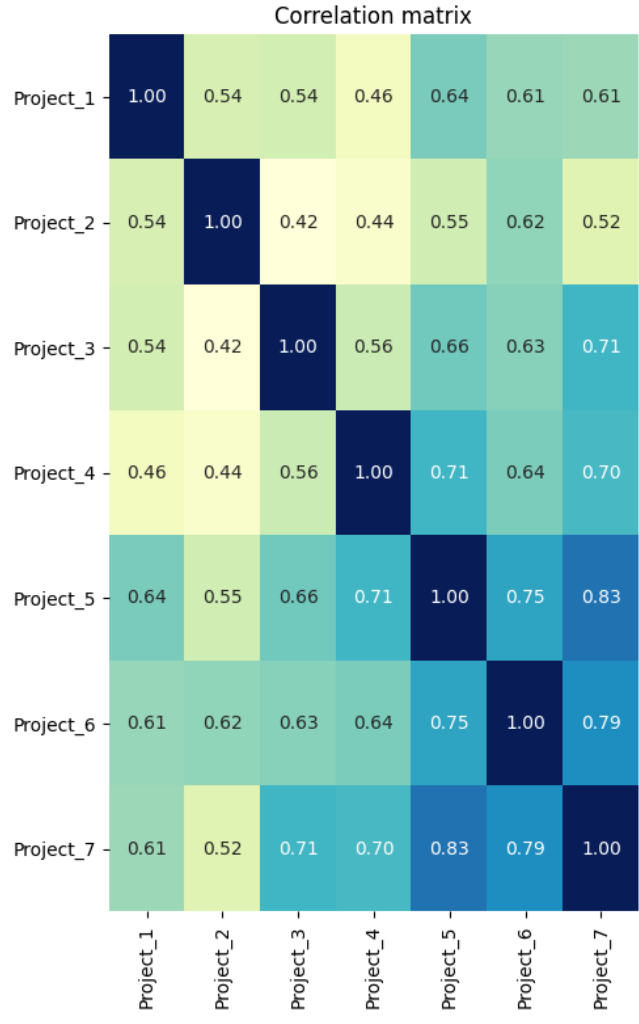
Figure 6. Correlation matrix between the projected specific value ( V R m т under consideration for the procurement of raw materials from corn waste.